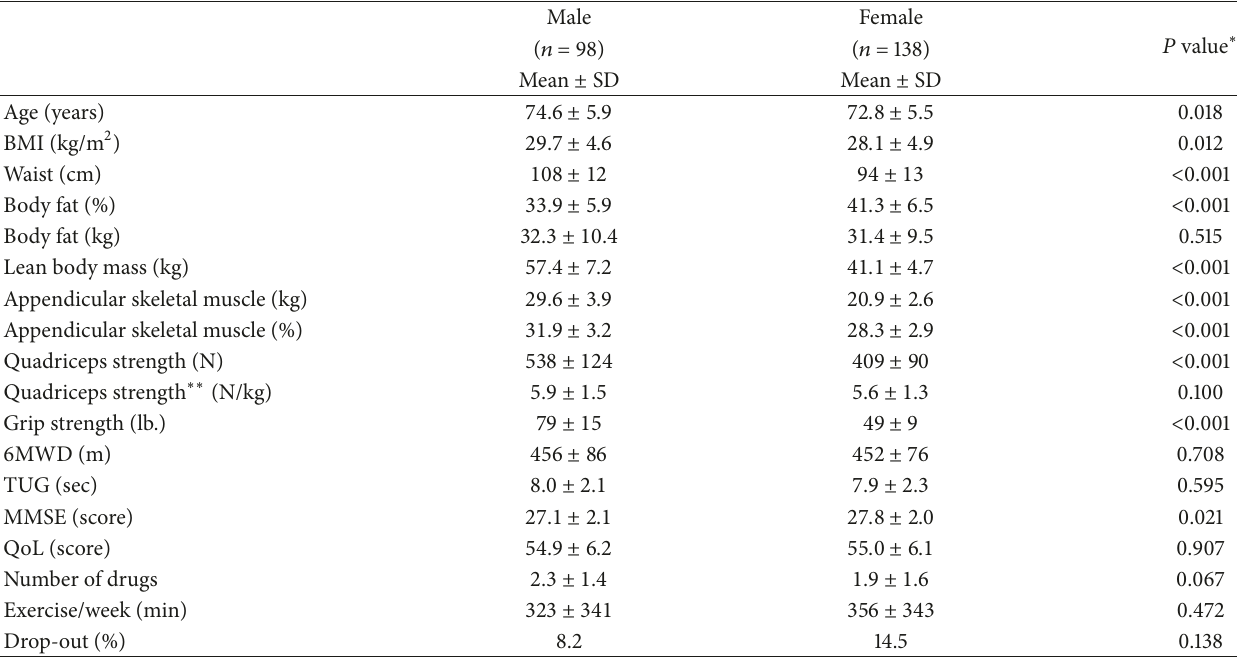
Table 1: Characteristics of male and female